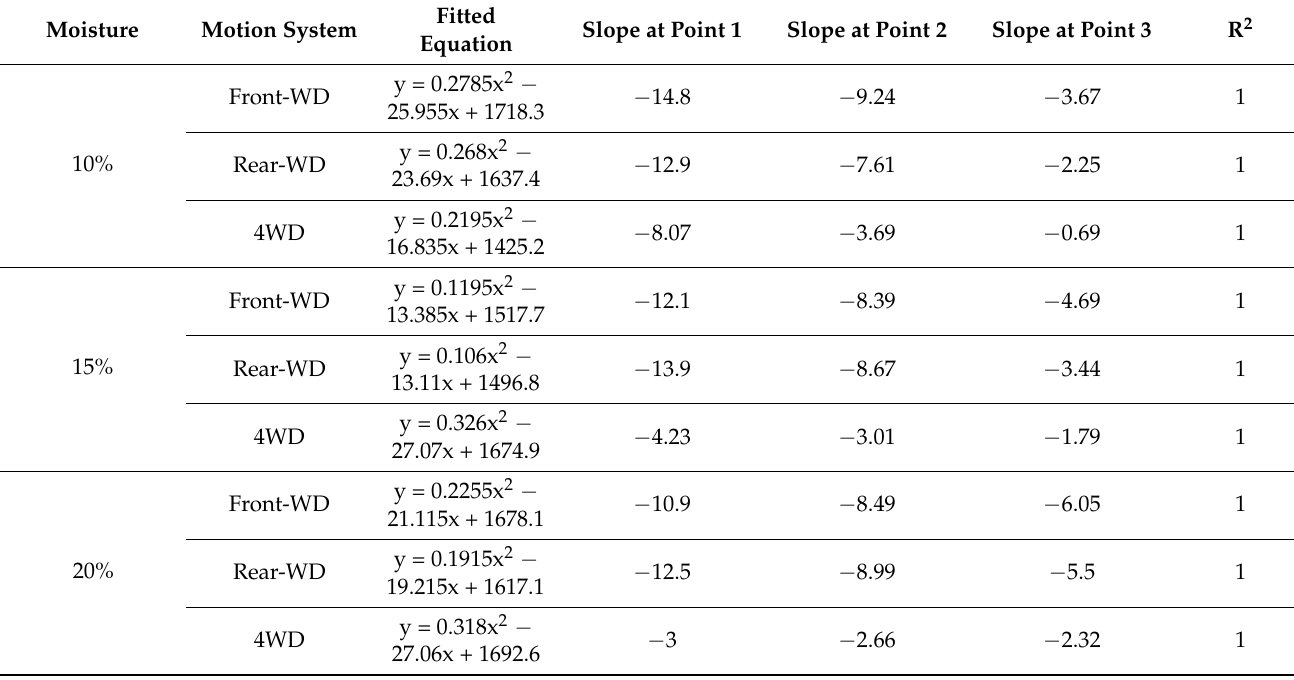
Table 3. Equations that fitted the curve bulk density relative to the depth, moisture (d.b.) and driving system type (the slope is obtained using a derivation).